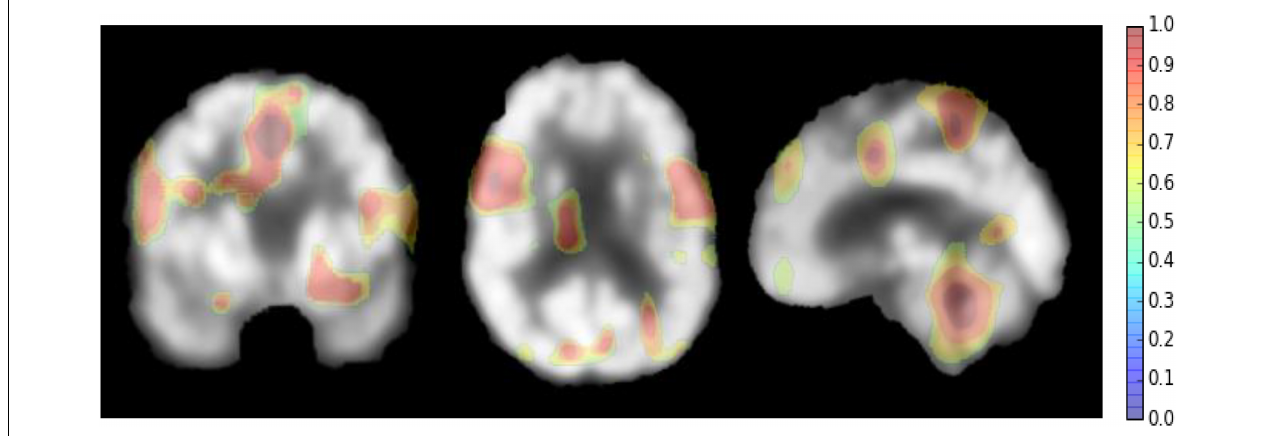
FIGURE 5 | The network attention areas for AD